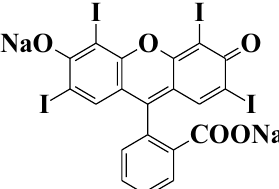
Fig. 1 Chemical structure of the dye erythrosine